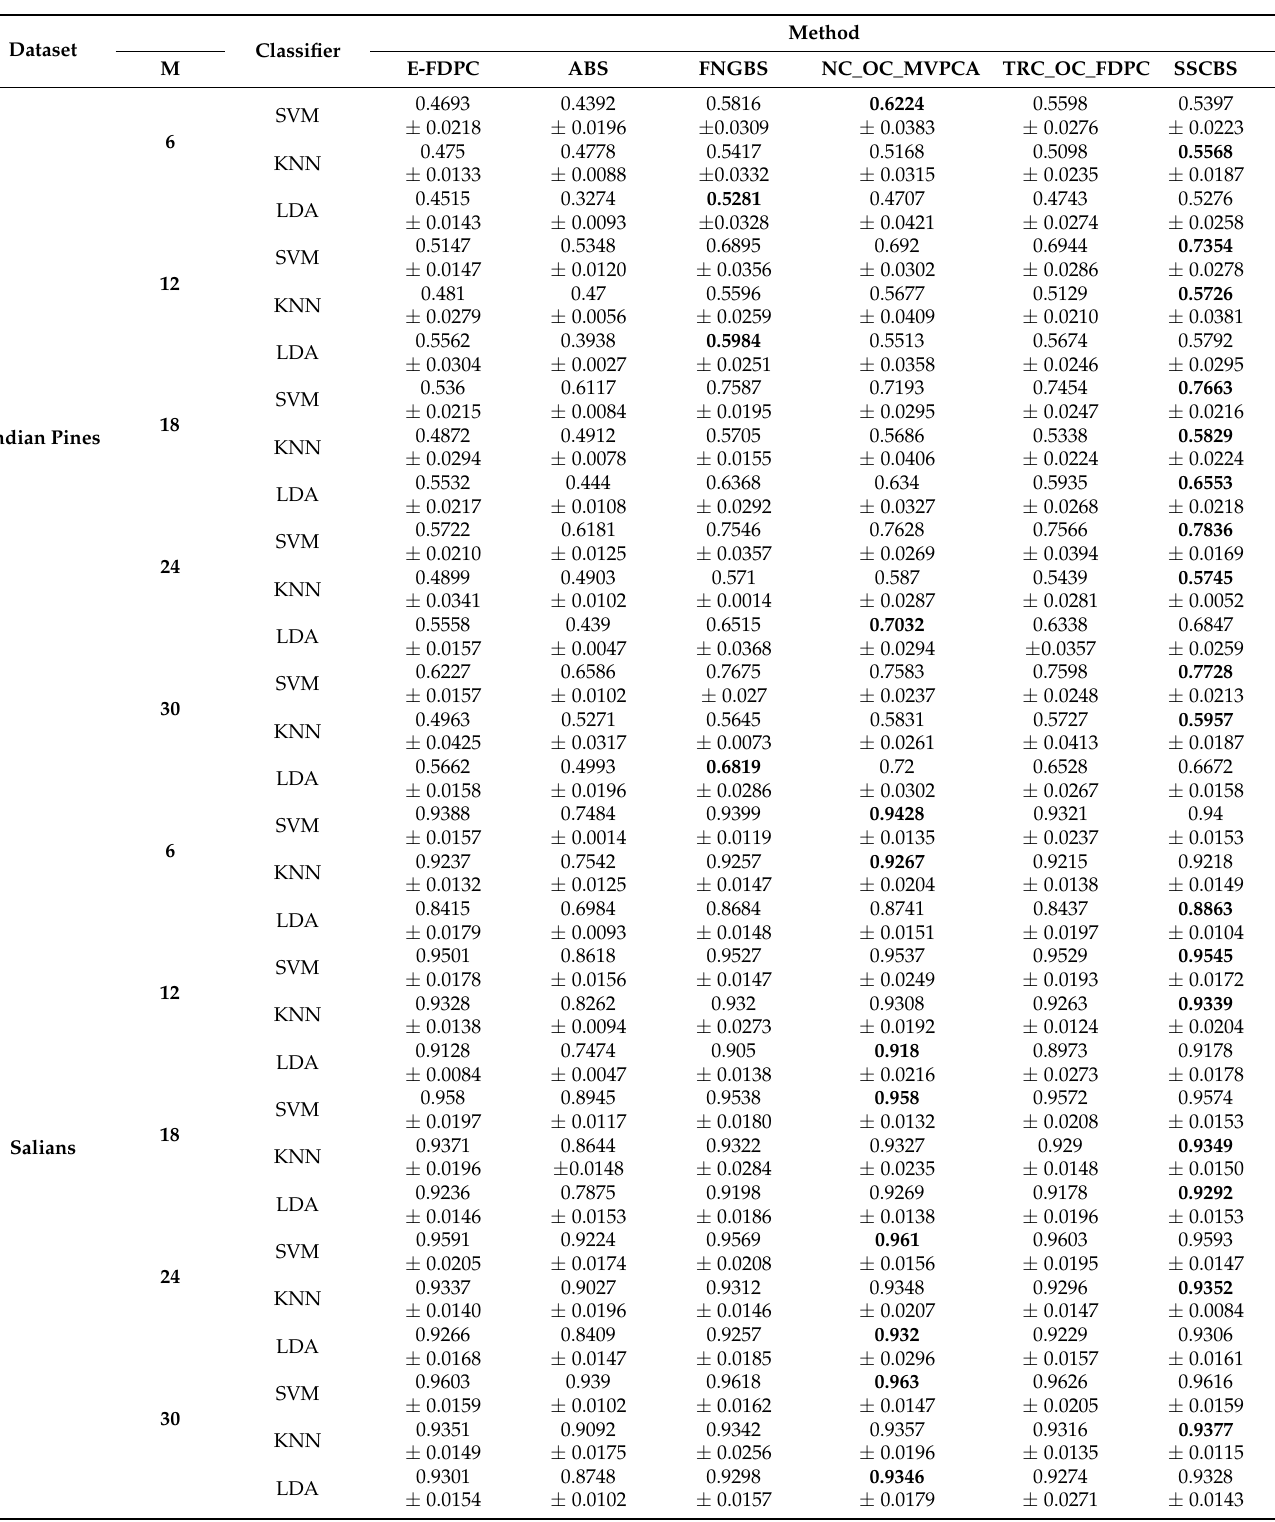
Table 2. Classification Results on Three Data